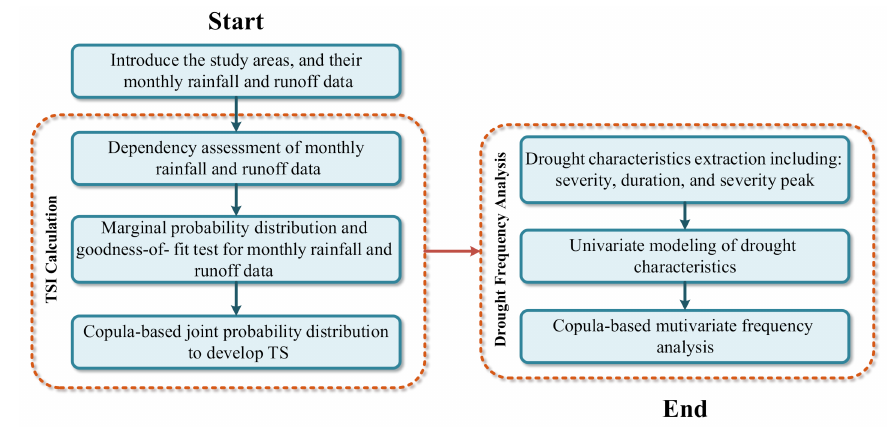
Figure 1. Methodology procedure